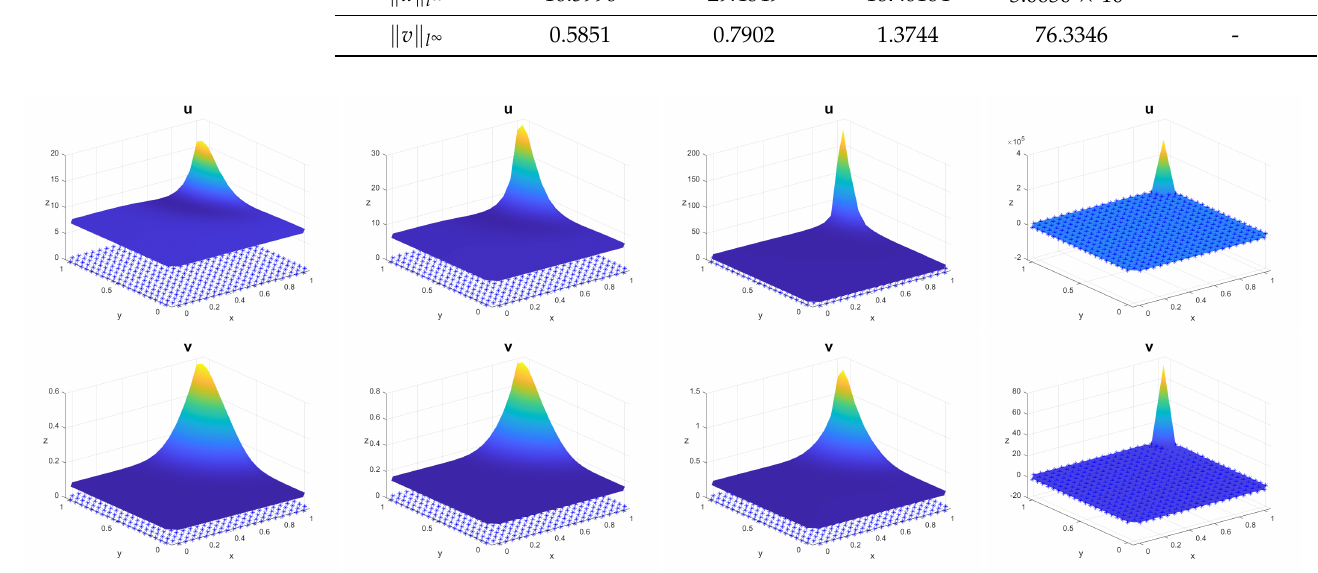
Figure 3. approximate solution o in the example 2 for 0.1, 0.2, 0.3 and 0.37